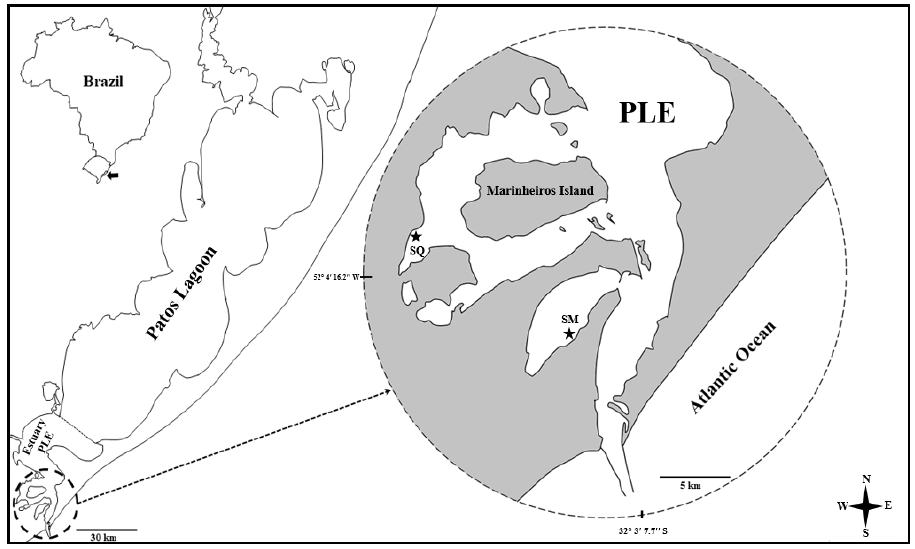
Figure 1. Location of the study area: two meadows of Ruppia maritima in the Patos Lagoon estuary (PLE) in the state of Rio Grande do Sul, Brazil. SQ = Saco da Quitéria, SM = Saco da Mangueira. Based on Google Earth.